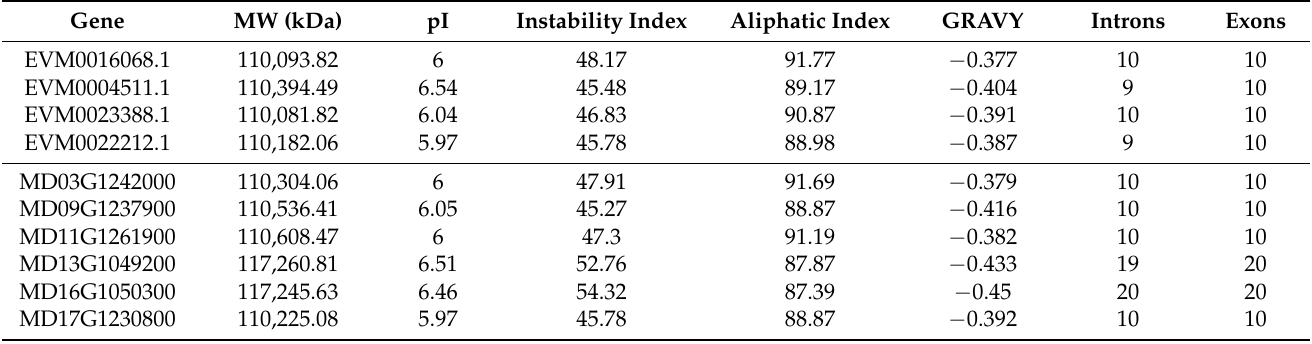
Table 3. Summary information of physiological and biochemical properties, and structural analysis of the PEPC proteins in five Rosaceae